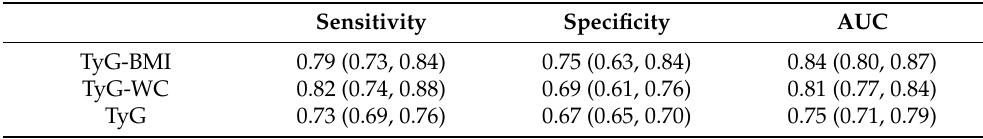
Figure 4. Pooled diagnostic parameters of TyG for MAFLD. ( A ) Representation of sensitivity against (1-specificity) in ROC curve for each study of TyG in the diagnosis and prediction for MAFLD. ( B ) SROC curve with pooled estimates of sensitivity and specificity and AUC of TyG in the diagnosis and prediction of MAFLD. ( C ) HSROC curve of diagnosis and prediction for MAFLD. ( D ) Bivariate Boxplot of the sensitivity and specificity in the include studies (The inner oval represents the median distribution, and the outer oval represents 95% CI boundary) (SROC: summary receiver operator characteristic; HSROC: hierarchical summary receiver operating characteristic; AUC: area under curve). Table 3. Summary diagnostic accuracy at Various Diagnostic Parameters for Diagnosis and Prediction for